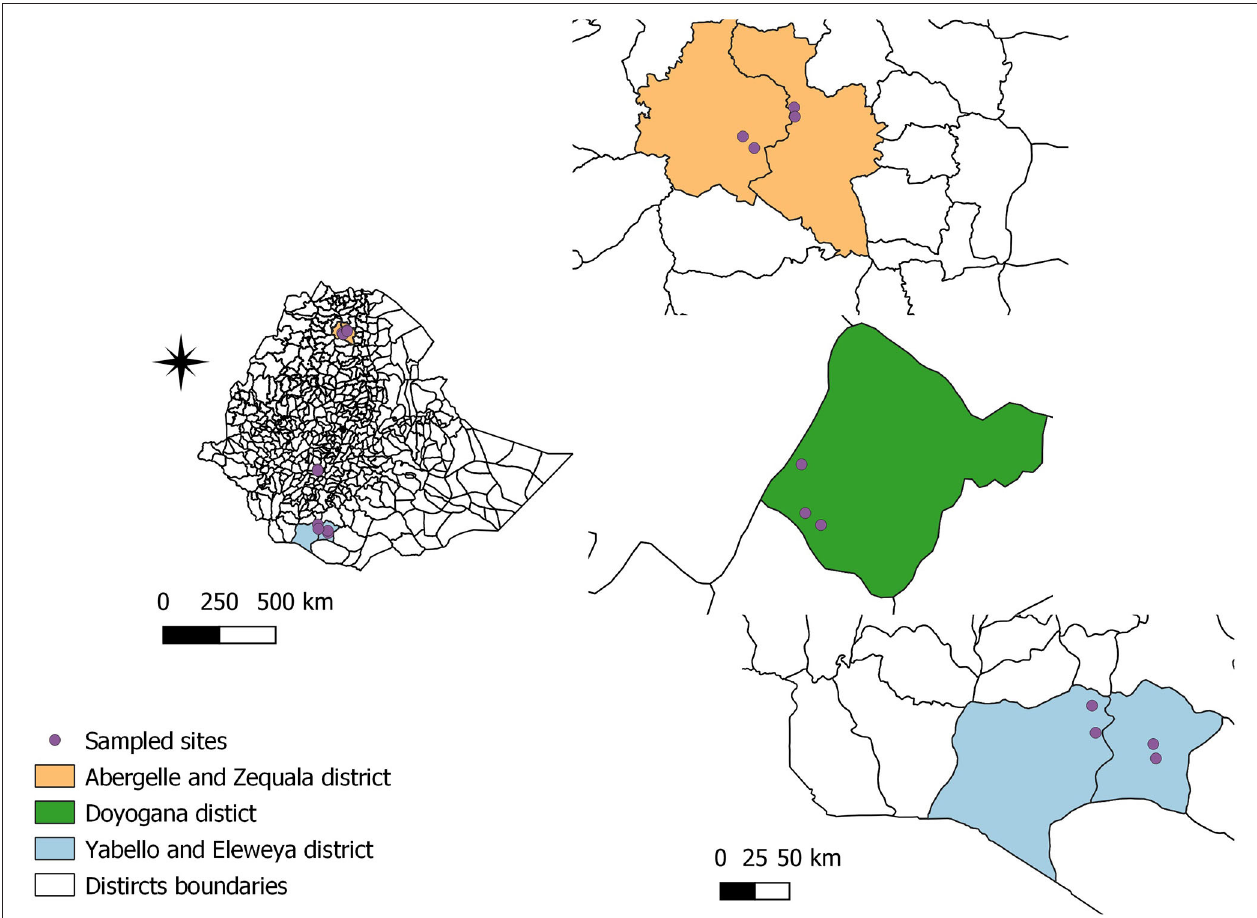
FIGURE 1 | Map of study locations.